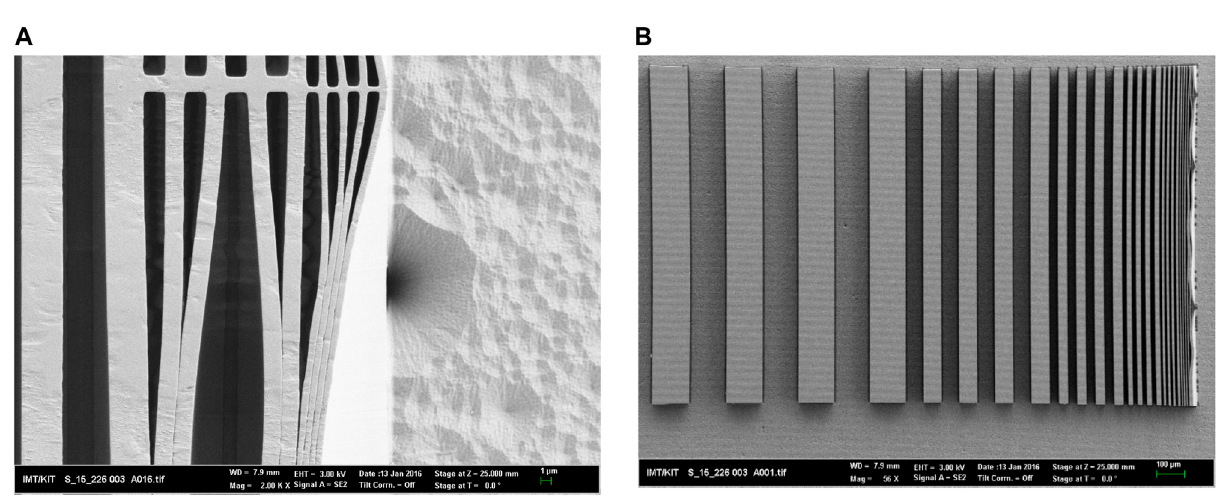
FIGURE 7 (A) SEM frontal view of the section with grid of high spatial frequency. The smallest usable aligned plates featured a width a/2 = 4 µm. The smaller lamellae(2 µm)bowedandtiltedagainsteachotherdestroyingperiodicityorevenmissopeninginbetween.Stabilizingbarsrectangulartotheselamellae havebeenimplementedinthedesign(top),butthesewereonlyabletokeepalignmentoftheplatesonlateraldistancesofabout10 – 30 µm. (B) Overview frontal SEM image of a well performing phantom. The grids shown range with periodicity a in between a i /2 = 128 μ m, 64, 32 16, 8 and 4 µm. All of them could be used for quantitative evaluation of the MTF [here in x -direction (left-right)]. The smaller ones exhibit bowing and non-aligned